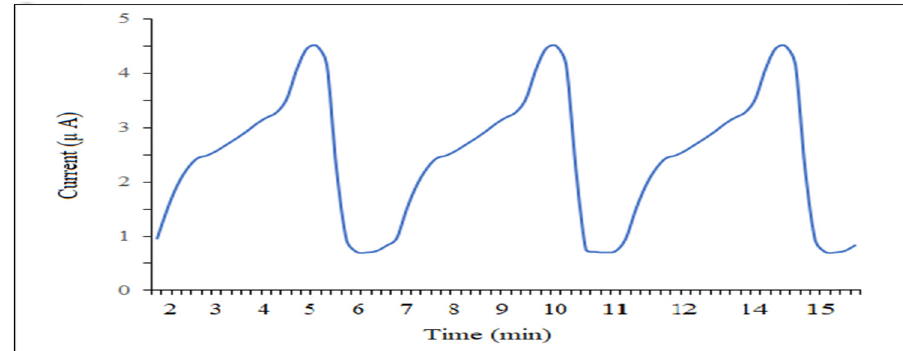
Figure 16: Half recti fi cation of current.